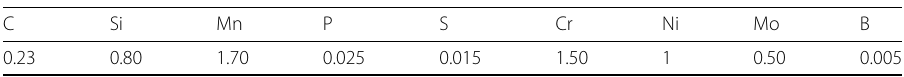
Table 1 Chemical composition of Raex ® 400 (maximum % of elements). The steel is grain refined C Si Mn P S Cr Ni Mo B 0.23 0.80 1.70 0.025 0.015 1.50 1 0.50 0.005